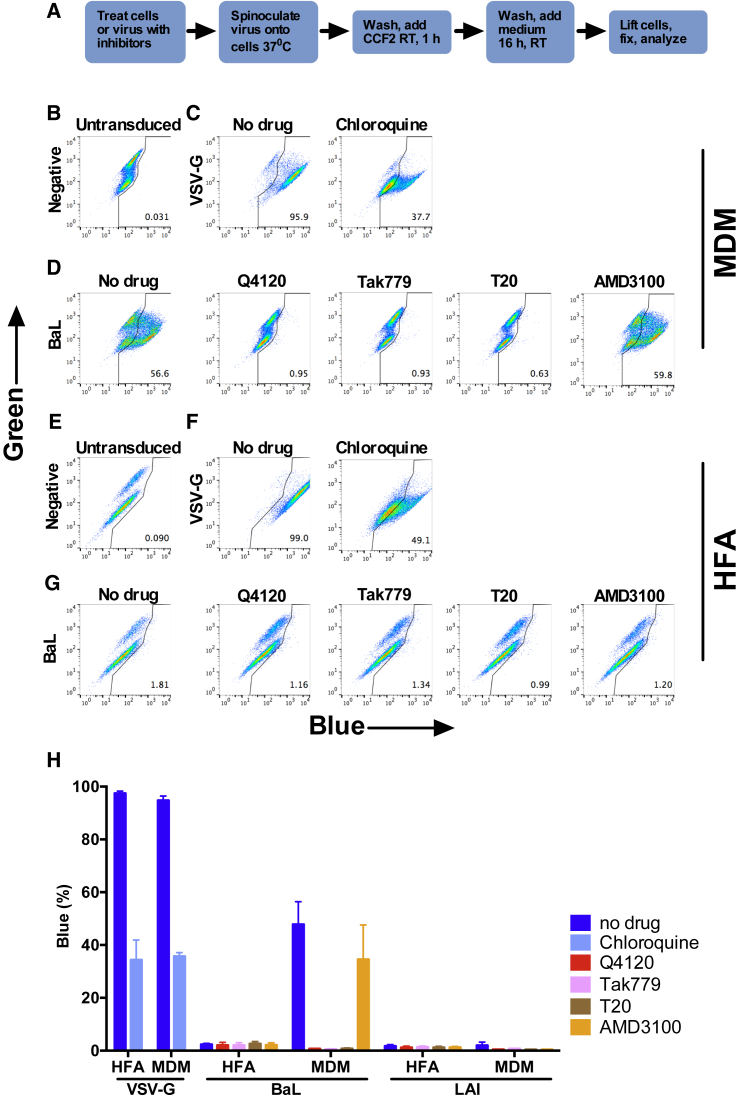
No Detection of HIV-1 Env Fusion with HFAs by BlaM-Vpr Assay(A) Experimental plan.(B–D) MDMs were untreated or treated with inhibitors and then mock-transduced (B) or transduced with VSV-G (C) or HIV-1 BaL Env-pseudotyped BlaM-Vpr HIV-1 (D) for 16 hr. Cells were then lifted, fixed, and analyzed by flow cytometry.(E–G) HFAs were untreated or treated with inhibitors and then mock-transduced (E) or transduced with VSV-G (F) or HIV-1 BaL-pseudotyped BlaM-Vpr HIV-1 (G) for 16 hr. Cells were then lifted, fixed, and analyzed by flow cytometry.(H) Means of data from three to five independent experiments ± SD using five MDM donors, including summarized results for LAI, presented in Figure S2.